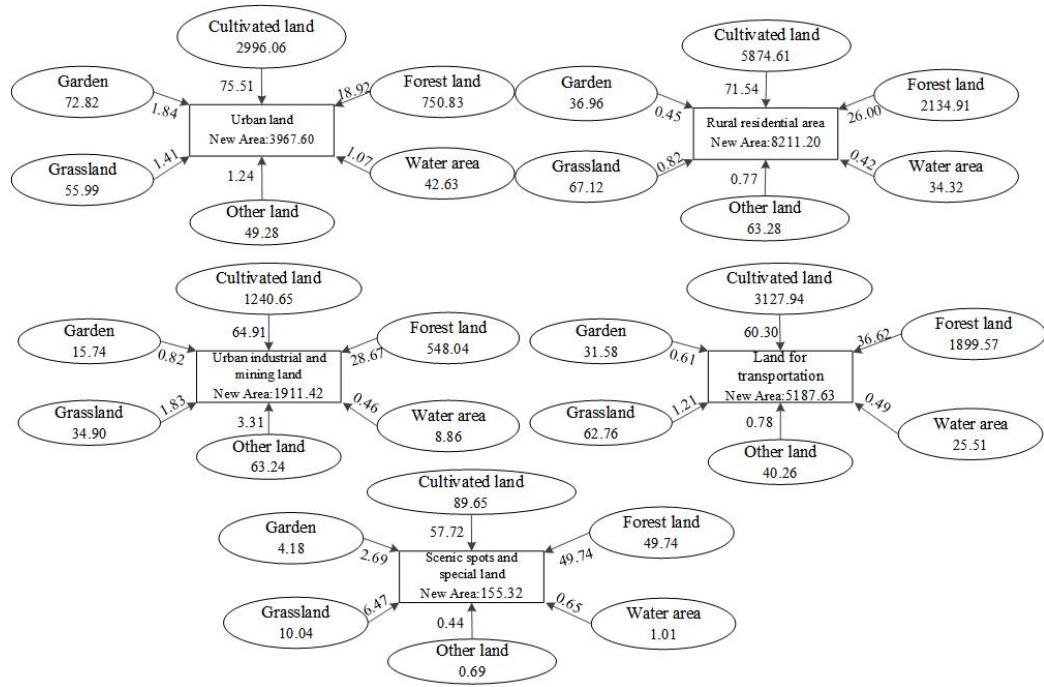
Figure 3. New sources of urban–rural construction land in Qixingguan District from 2009 to 2020 (hm 2 , %).